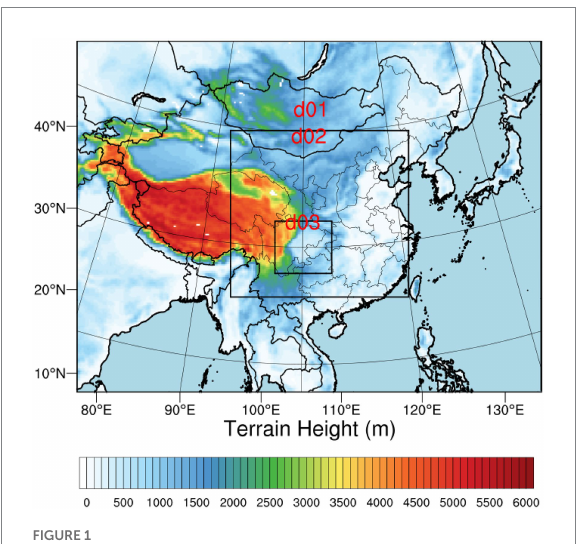
FIGURE 1 Three-nested domains of WRF-CMAQ modeling